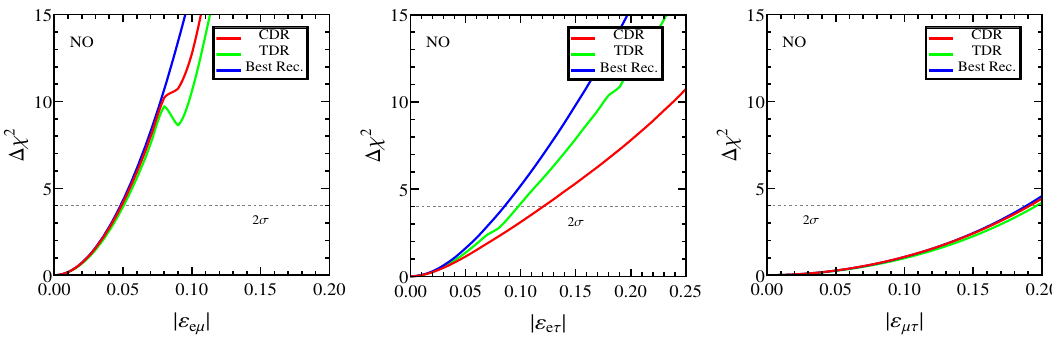
Figure 4 . Same as in figure 3 for the non-diagonal NSI parameters ε eµ , ε eτ , and ε µτ , but now assuming them to be complex and marginalizing over their phases.